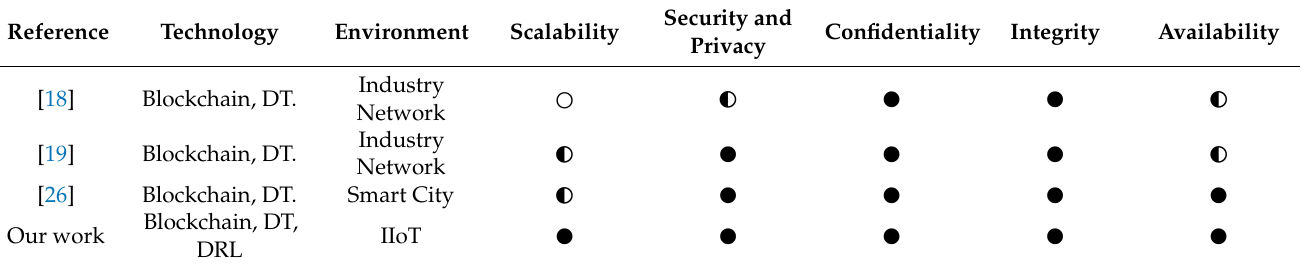
Table 2. Key consideration comparation with other related works.